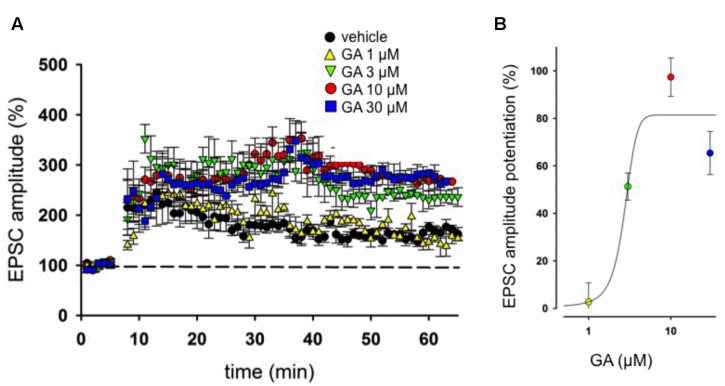
Ginkgolic acid (GA) modulates long term potentiation (LTP) in hippocampus.
(A) Superimposed pooled data showing the effect of GA (1–30 μM) on LTP compared to control. (B) Concentration-response curve showing the effects of GA on the Excitatory post-synaptic currents (EPSC; measured as % of control) 1 h after induction of LTP. Each plot represents the recording of at least six separate neurons.